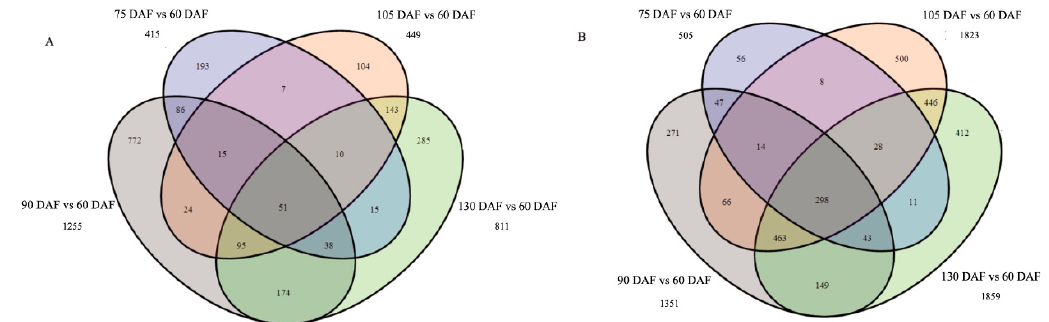
Figure 3. Venn diagram showing all of the differentially expressed genes during development of L. cubeba fruit. ( A ) shows all DEGs were the up-regulated in the four contrasts; and ( B ) means all DEGs down-regulated in the four contrasts. The number in one circle represents the numberof stage-specific genes, and the number in two or more intersecting circles represents the number of overlapped genes.